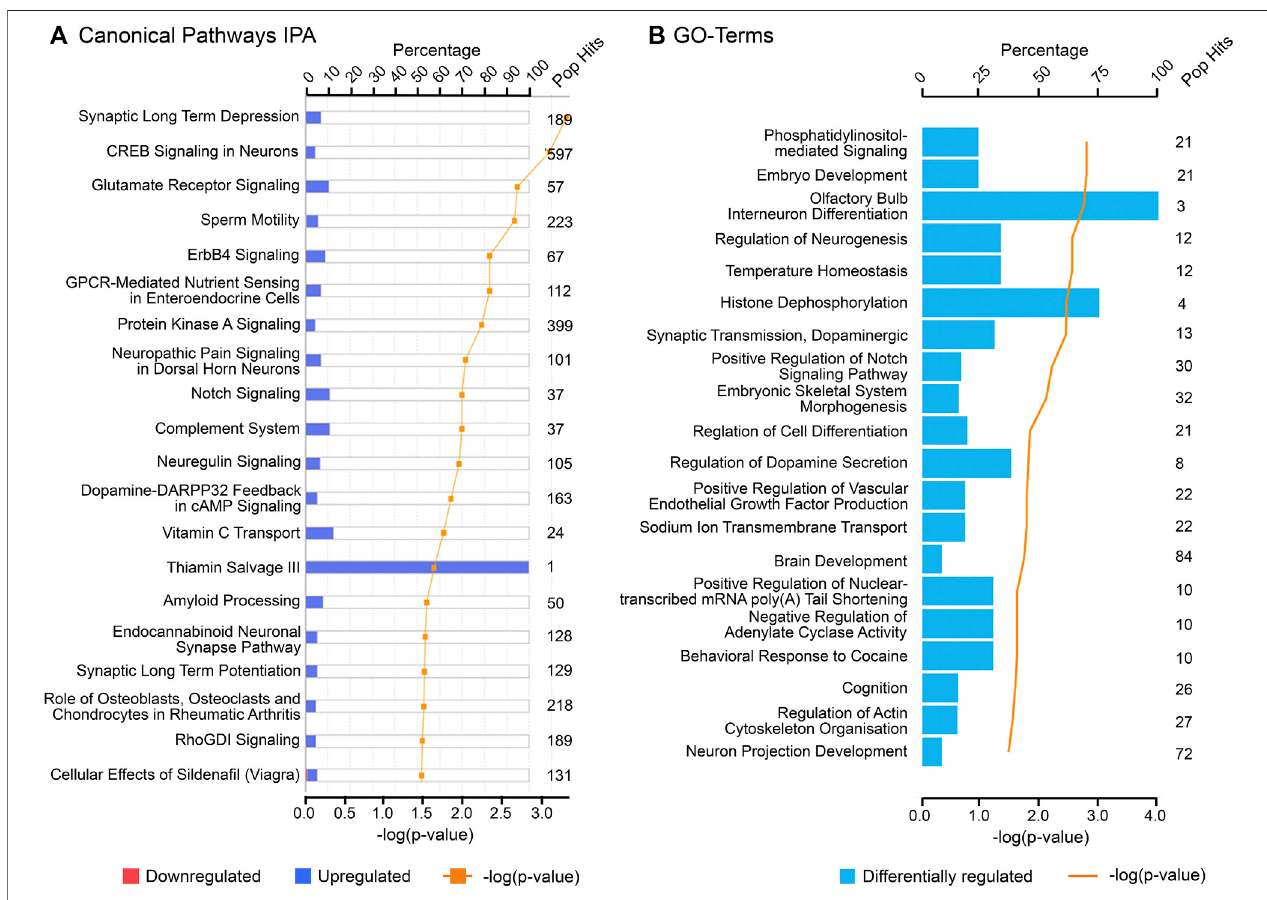
FIGURE 6 | Top canonical pathways associated with cluster 3 ( “ throughout ” genes) using (A) Ingenuity Pathway Analysis (IPA) and (B) Gene Ontology (GO), biologicalprocessesfromDAVIDdatabase. “ PopHits ” referstothetotalnumberofgenesassociatedwitheachofthepathwayinthedatabase.Thebargraphsrepresent the percentage of genes from the data set that map to each canonical pathway whilst the orange line shows the p -value of overlap between genes in each cluster and a given pathway.